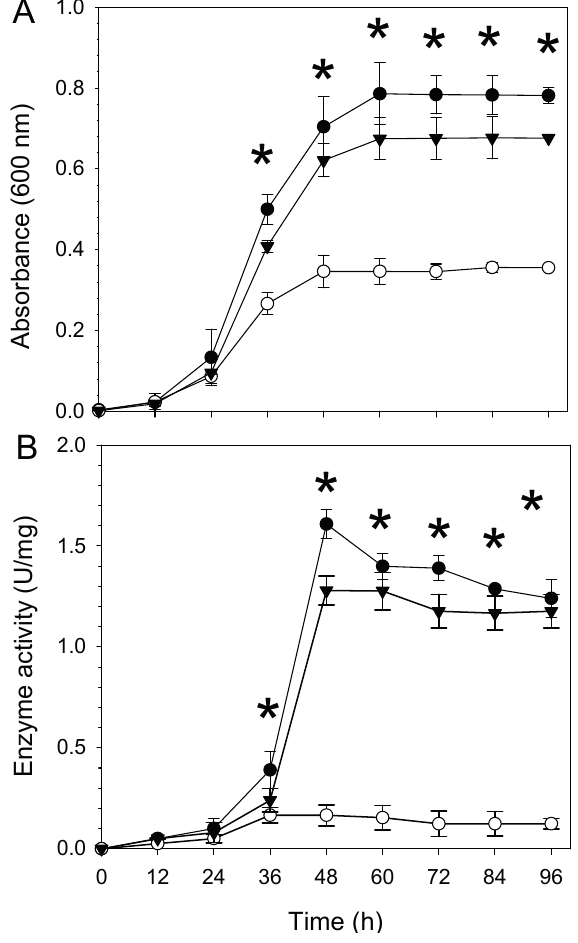
Figure 3. Effect of salt stress (70 mM NaCl) on ( A ) growth of the three B. japonicum strains (wild type, aceA mutant WC2455, and aceA complemented strain WC2455-C) in AG medium and ( B ) their ICL enzyme activities. One unit of ICL activity was defined as the amount of enzyme required to produce 1 μ mol of glyoxylate per min at pH 6.8 and 30 °C. Symbols: ● , wild type; ○ , WC2455; ▼ , WC2455-C. Asterisks indicate significant differences between the wild type and the mutant using t -test ( p <